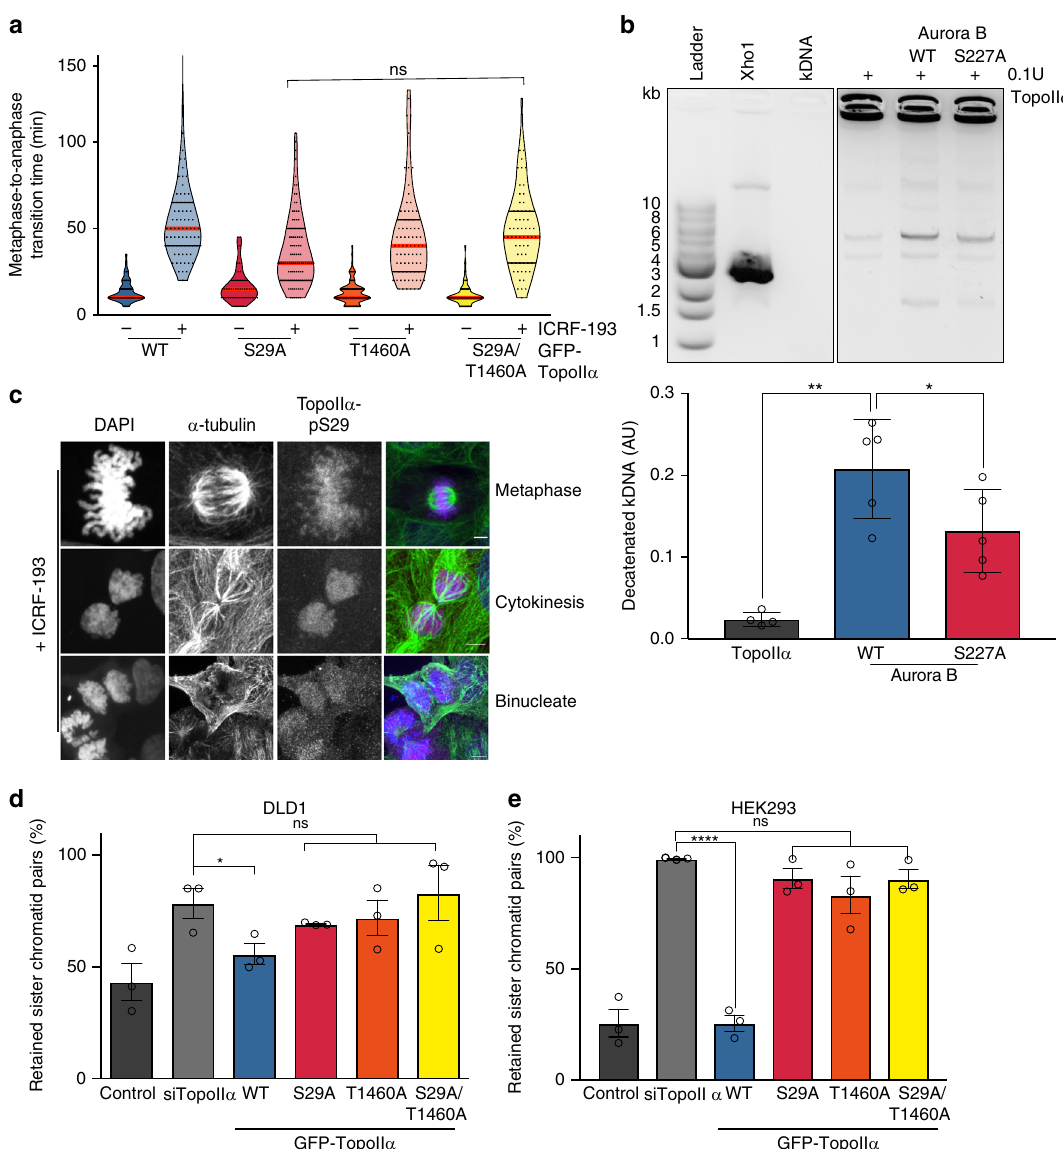
Fig. 5 Phosphorylation is required for enhanced TopoII α decatenation. a DLD1 cells induced to express GFP-TopoIIa wild type or mutants were assessed for the metaphase catenation response. Cells were treated ±1 μ M ICRF193 immediately prior to time-lapse imaging and scored for the time to progress from metaphase to anaphase. The mean± SEM of three independent experiments is represented by the graph, ≥ 100 cells per condition were analysed. (one-way ANOVA; WT + ICRF193 55.6±2.23 min S29A + ICRF193 44.18 ± 6.69 min, T1460A + ICRF193 46.11±2.77min, S29/T1460A + ICRF193 45.52±1.71 min). b In vitro decatenation assay. Quanti fi cation of the amount of decatenated kDNA present after addition of TopoII α and recombinant Aurora B (wild type or S227A). Graph represents the mean ±SD of fi ve independent experiments. (two-tailed Students ’ t test, * P = 0.012, ** P = 0.0025; Control 0.024± 0.009, WT 0.208 ± 0.06, S227A 0.132± 0.05). c Representative immuno fl uorescence images of DLD1 cells after 1 h treatment with ICRF193 (1 μ M) showing TopoII α pS29 (magenta), a-tubulin (green) and DNA (blue). Images are representative of three independent experiments. Scale bar = 5 μ m. d , e Catenation spread assay analysis. d DLD1 cells induced to express GFP-TopoII α wild type or mutants were scored for the per cent joined (catenated) chromatids. The mean± SEM of three experiments where ≥ 15 cells per experiment were analysed is represented by the graph. (two-tailed Students ’ t test; * P = 0.047; siControl 43.38%± 8.22, siTopoIIa 78.64% ±6.61, WT 55.88% ±4.58, S29A 69.24%± 0.36, T1460A 72.07% ±7.94, S29/T1460A 83.17% ± 12.49). e HEK293 cells induced to express GFP-TopoIIa wild type or mutants were scored for the per cent joined (catenated) chromatids. The mean ±SEM of three experiments where ≥ 15 cells per experiment were analysed is represented by the graph (two-tailed Students ’ t test; **** P = ≤ 0.0001; siControl 25.66% ± 6.17, siTopoIIa 99.57% ±0.26, WT 25.62% ± 3.63, S29A 90.68% ± 4.44, T1460A 83.21%± 8.47, S29/T1460A 90.46%±